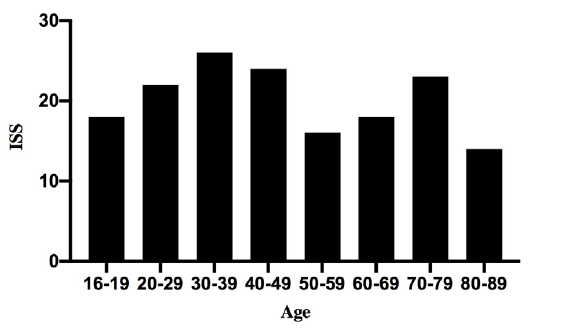
Figure 3. Descriptive statistics of ISS by age